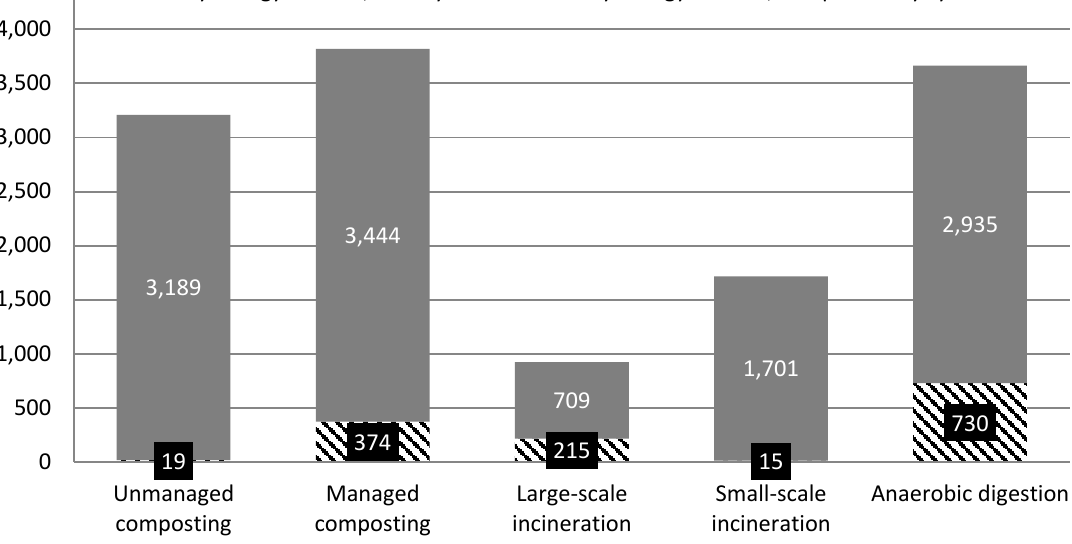
Figure 2. Use of primary energy (CED) in simulated scenarios.